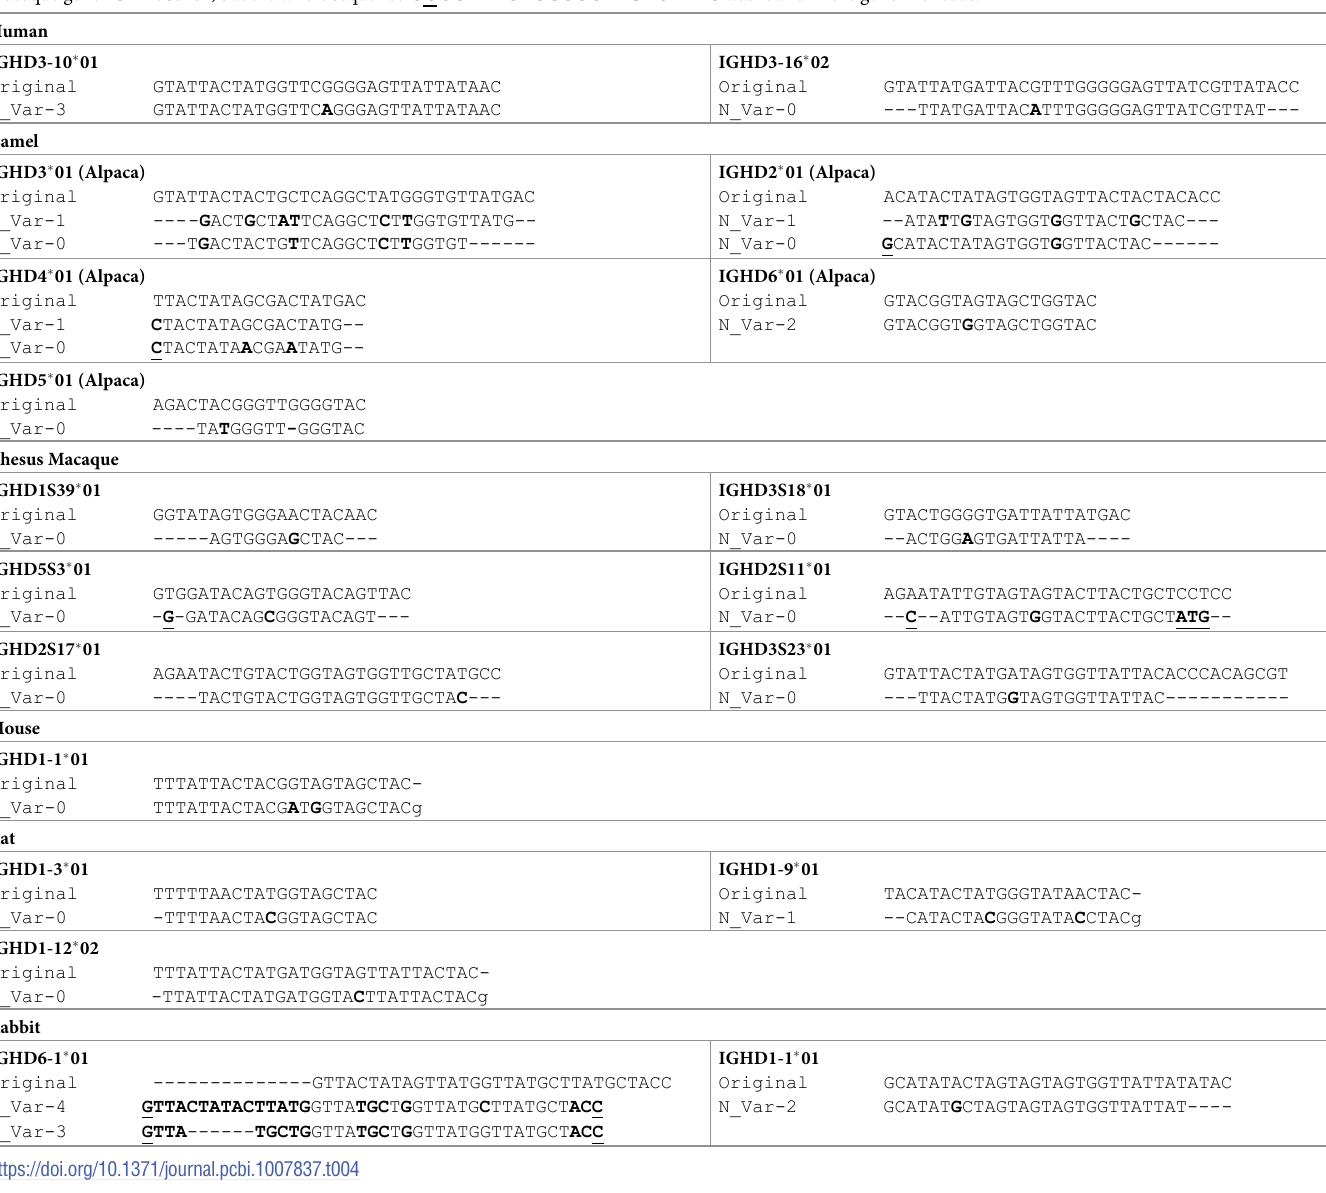
Table 4. Novel variations of D genes validated using genomic data from human, camel, rhesus macaque, mouse, rat, and rabbit datasets. “Original” refers to the sequence in the IMGT database. In three of the inferred sequences, there is an extra nucleotide at the end that was not found in the genomic reads, e.g., the novel variation inferred from mice datasets TTTATTACTACG A T G GTAGCTACg is only present as TTTATTACTACG A T G GTAGCTAC in the genomic reads. Other polymorphisms that were found using genomic validation of the inferred genes are underlined. For example, GATACAG C GGGTACAGT was inferred by MINING-D as a variant of the macaque gene IGHD5S3 � 01, but the whole sequence G G GGATACAG C GGGTACAGTTAC was found in the genomic